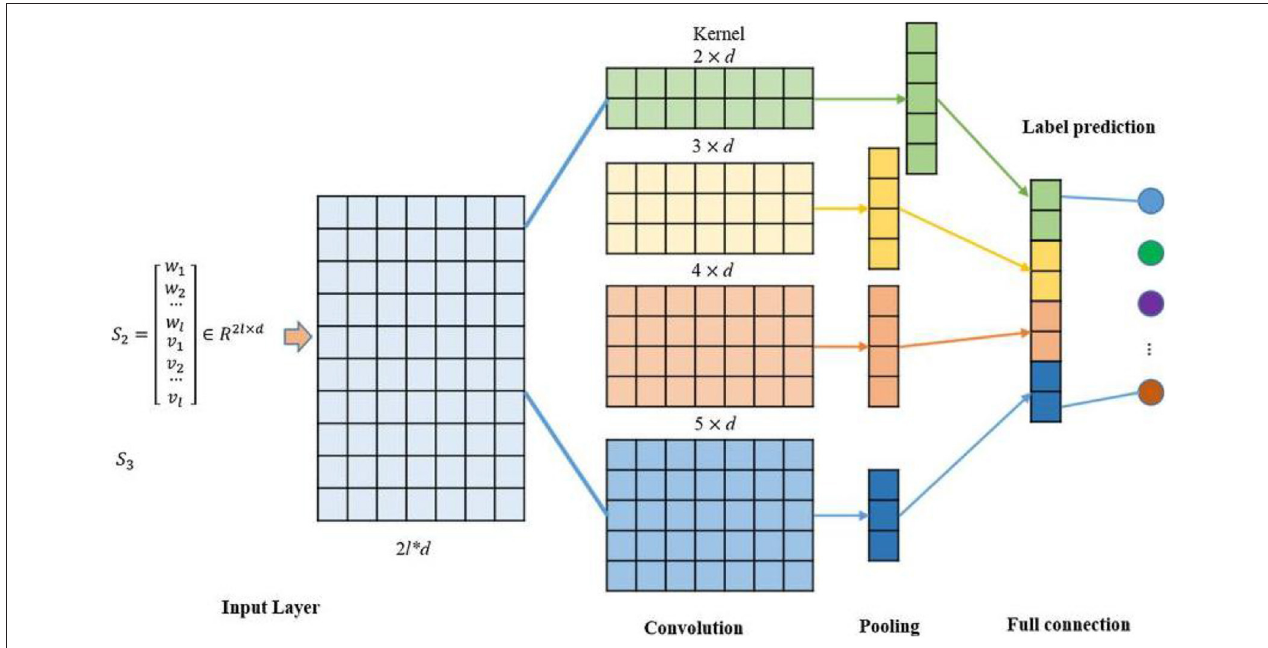
FIGURE 4 | Convolutional neural